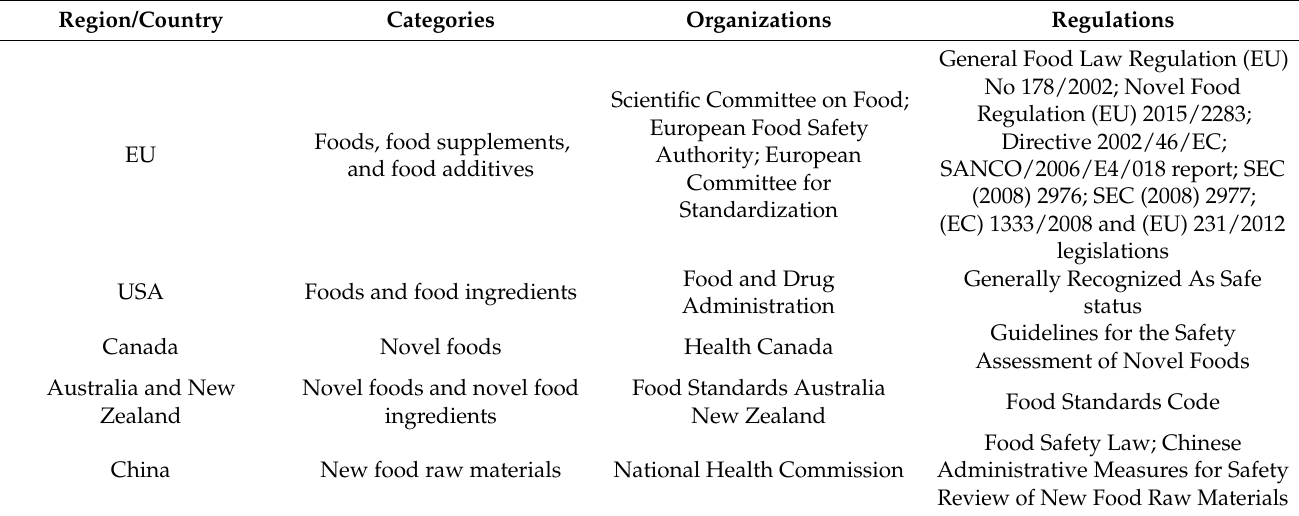
Table 2. Legislation on edible algae species as food